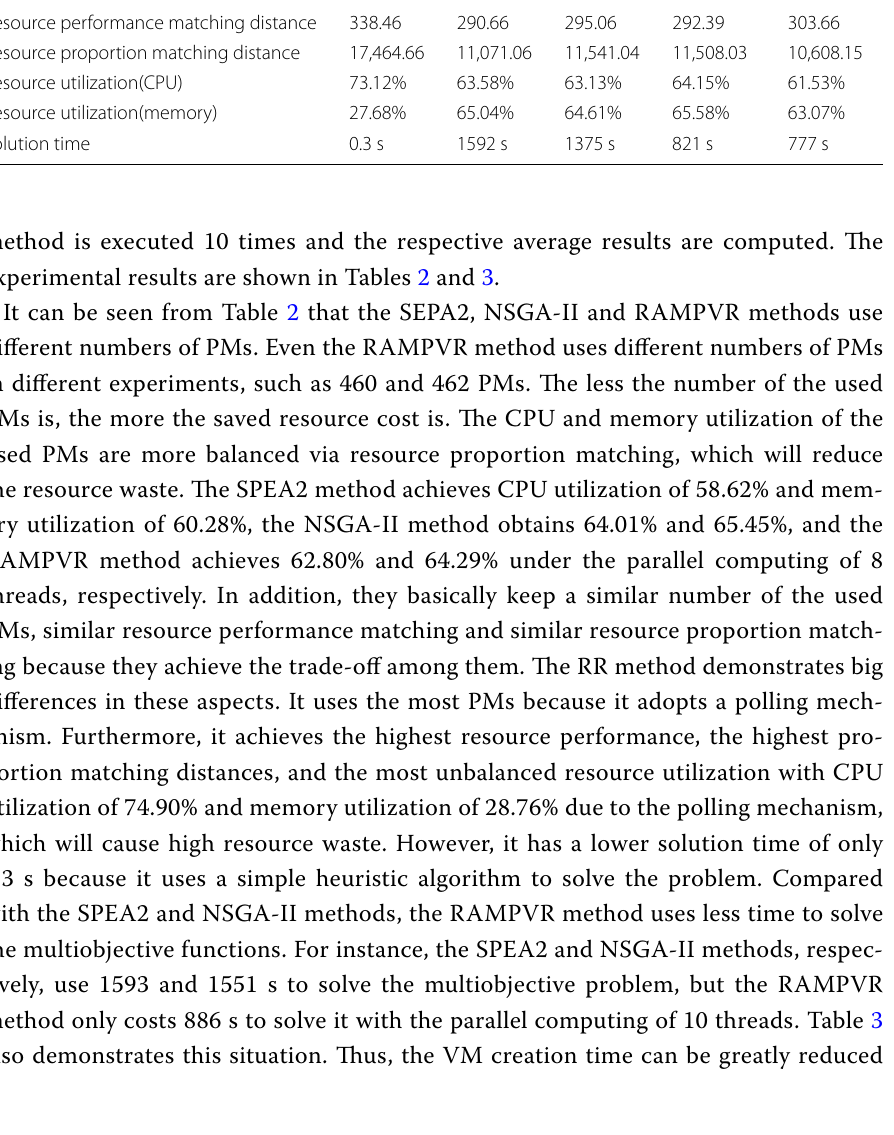
8 Threads 10 Threads